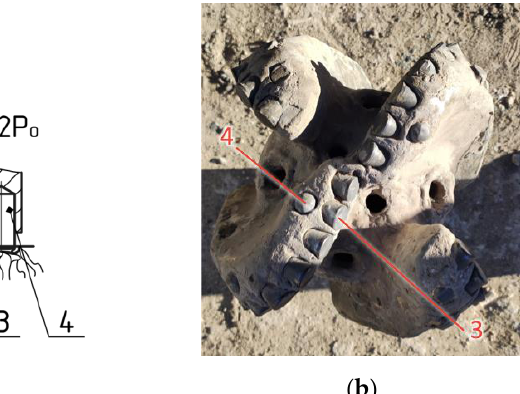
Figure 5. Positions of cutting inserts along the circle of radius R i : ( a ) Schematic view; ( b ) Photo of the PDC drill bit.